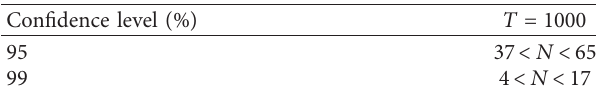
Table 1: The comparison table of back-testing acceptance confi- dence interval.